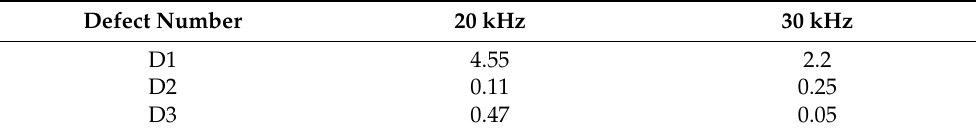
Table 3. The temperature increase over defects by thermal stimulation with ultrasounds.